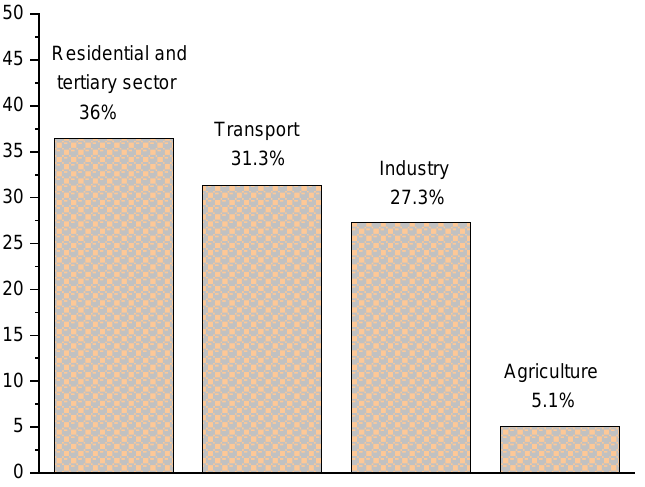
Figure 1. Final energy consumption in 2020 with respect to sector in Tunisia [9].